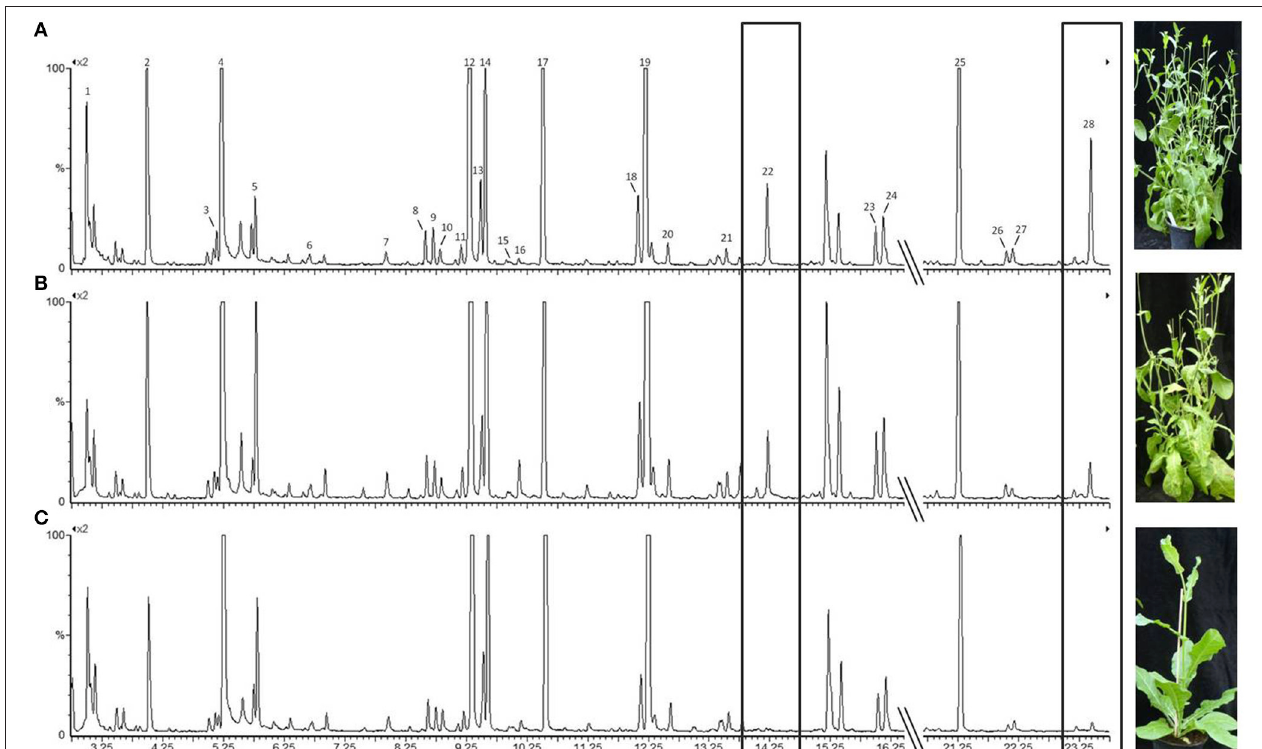
FIGURE 2 | Total ion current chromatogram obtained from GC-MS analysis of odor spectra of tobacco plants under different infection conditions. The visible symptoms (shoot proliferation) caused by the respective phytoplasma strain are shown in the photograph. (A) infected by the virulent strain; (B) infected by